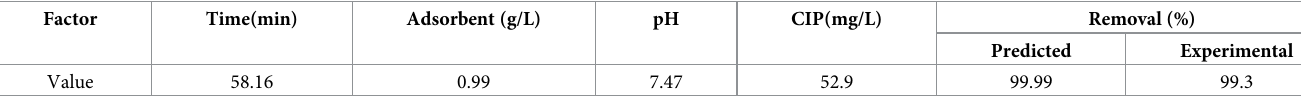
Table 7. Optimum values for each independent variable obtained from model optimization.